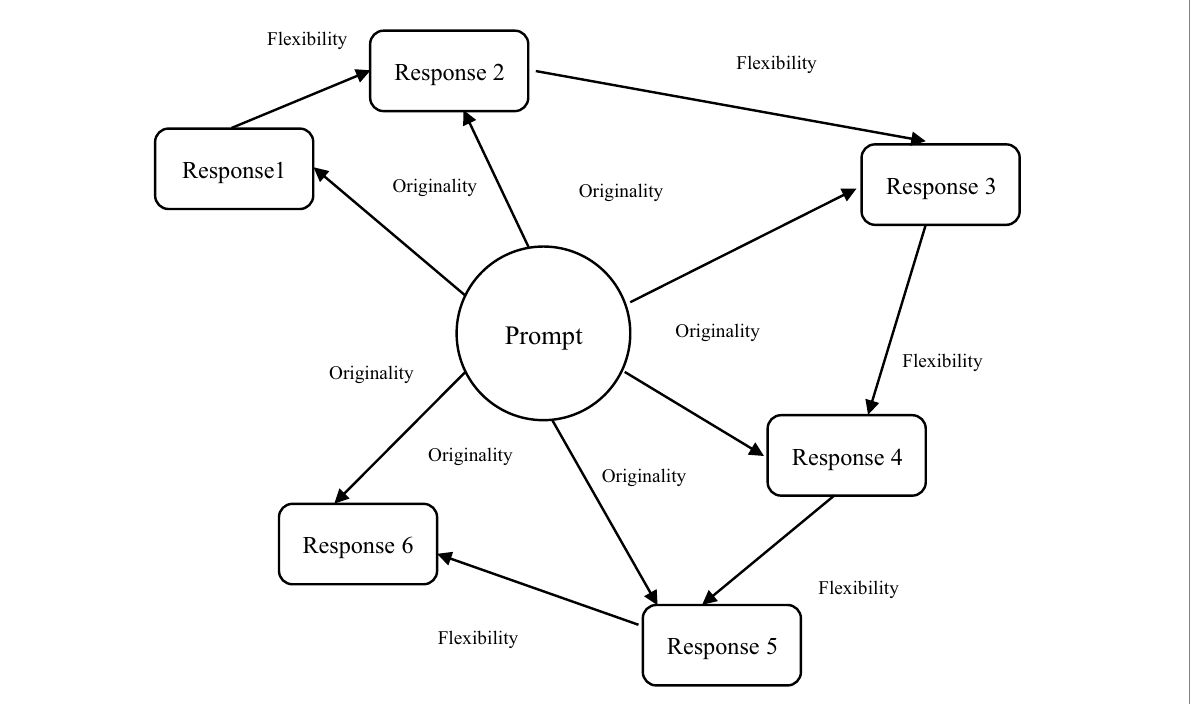
FIGURE 2 Flexibility as semantic distances between consecutive answers. The differing lengths of the arrows are meant to conceptually depict the varying semantic distance between prompt and responses for originality and between responses for flexibility. The model is based on Acar and Runco